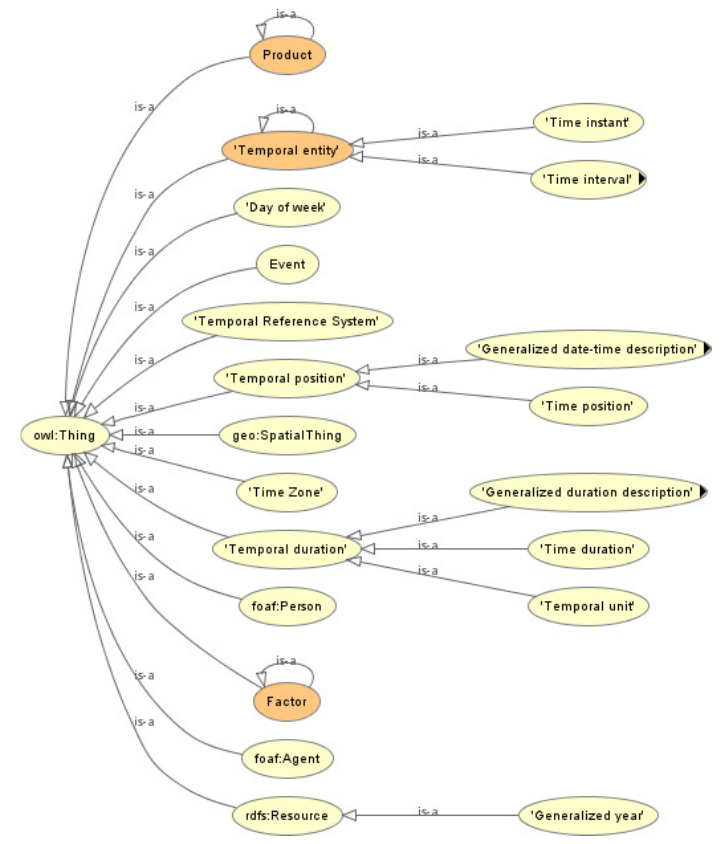
Fig. 6. General abstract classes of the event